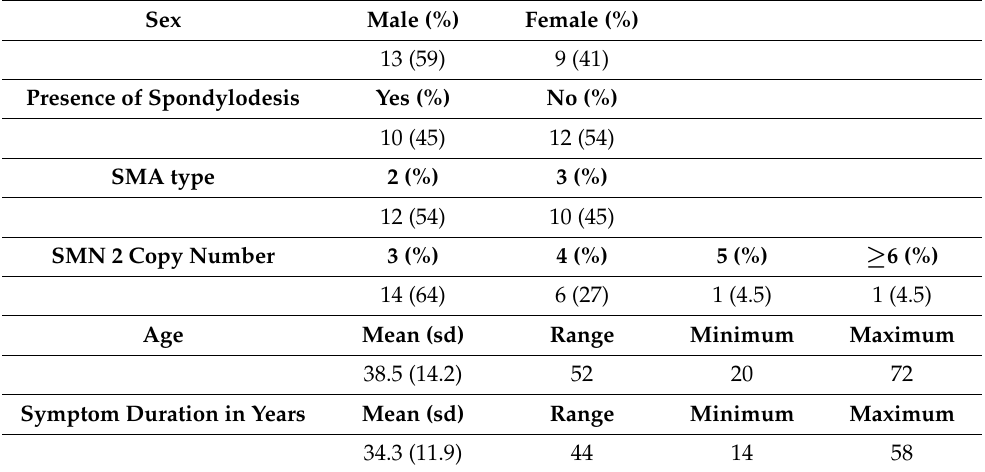
Table 1. Demographic and clinical characteristics of all patients ( n =